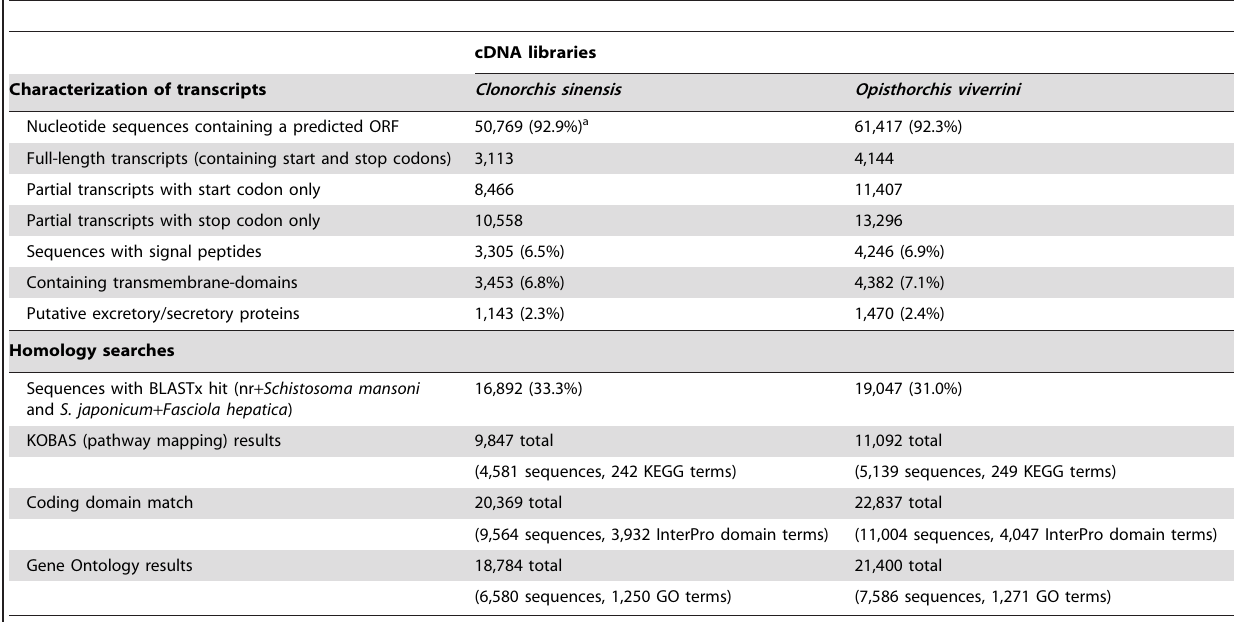
Table 2. Summary of the bioinformatic analyses performed on the amino acid sequences encoded by the transcriptome of the adult stage of Clonorchis sinensis and Opisthorchis viverrini .